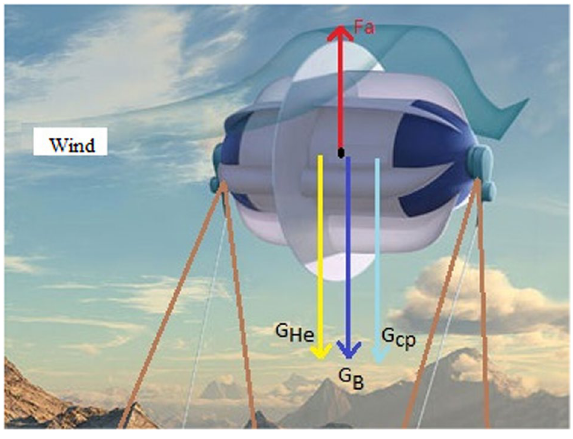
Fig. 12 The forces that appear and influence the rise of the rotor (Vasilescu